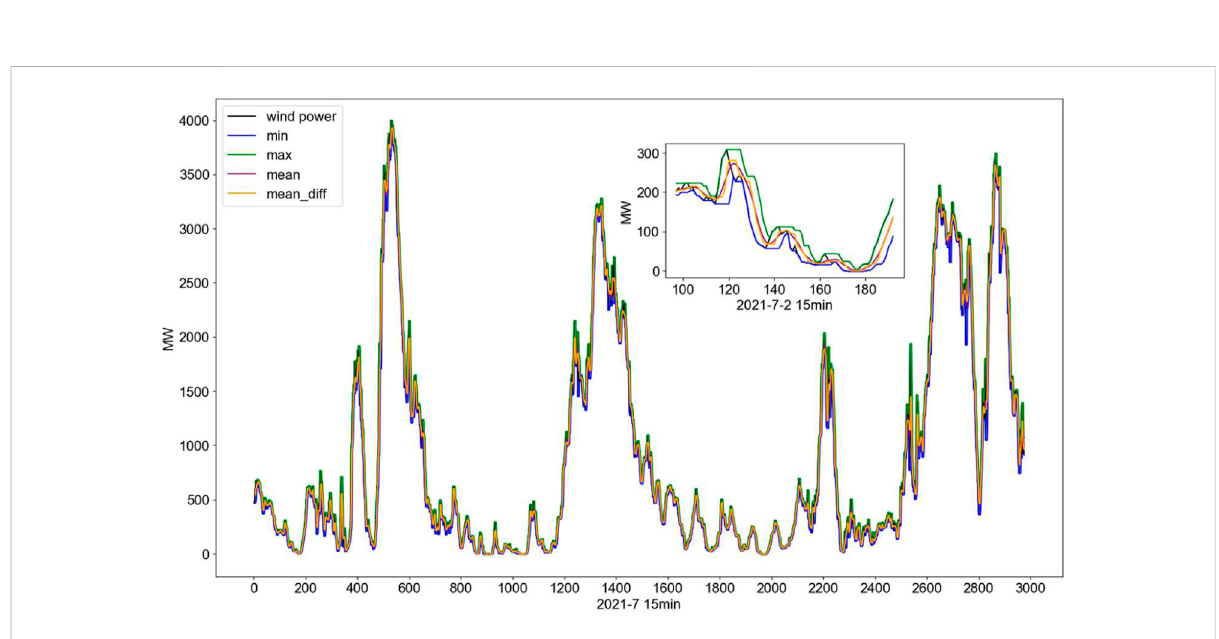
FIGURE 4 Curve features for wind power from Belgium in July